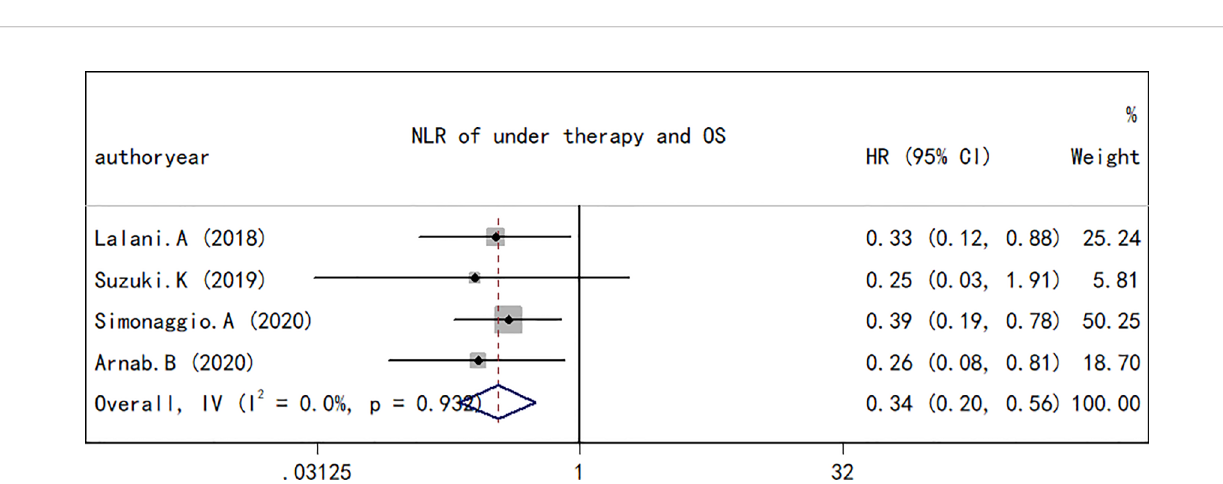
FIGURE 3 | Forest plot of hazard ratios for the association between the neutrophil-to-lymphocyte ratio at baseline or pre-therapy and progression-free survival in renal cell